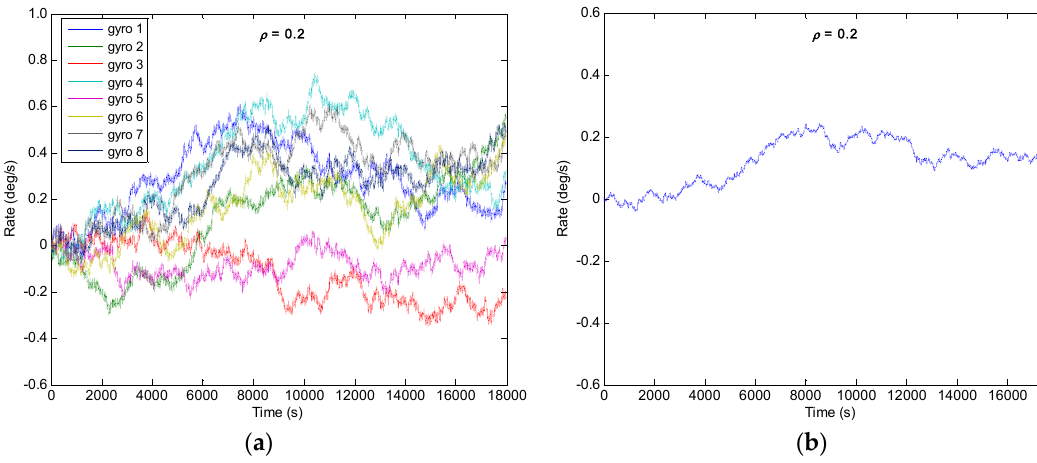
Figure 6. Filtering result of gyroscope array with ρ = 0.2: ( a ) Outputs of component gyroscopes; ( b ) Output of combined gyroscope.